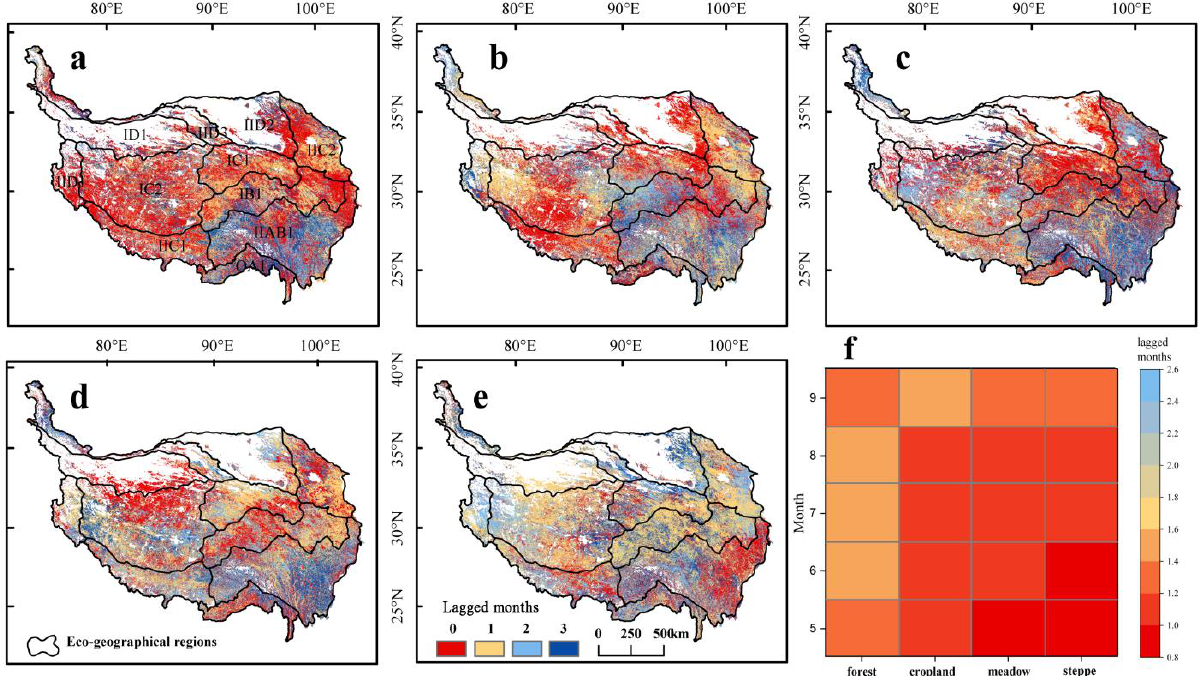
Figure 4. Spatial distribution of the corresponding lagged months where the largest correlation coefficient r max−lag occurred. ( a ) May, ( b ) June, ( c ) July, ( d ) August, and ( e ) September. The corresponding lagged months (i) of different vegetation types when r max−lag occurred ( f ).